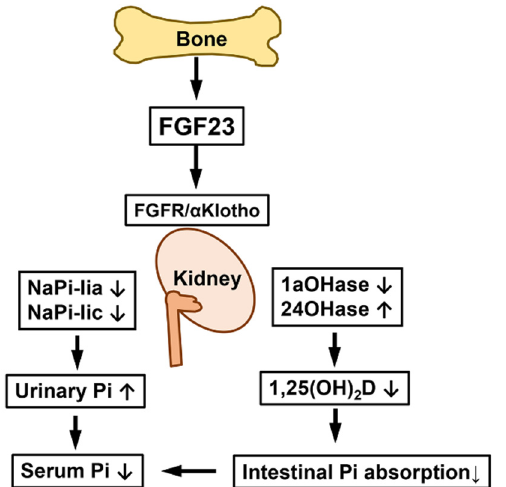
Figure 1. Effects of FGF23 on kidneys. FGF23 produced in bone binds to FGFR and α Klotho in the kidneys and suppresses the renal expression of NaPi-IIa and NaPi-IIc Na + /Pi co-transporters, which increases urinary Pi excretion and reduces serum Pi levels. In addition, FGF23 decreases the production of 1,25(OH) 2 D by the down-regulation of 25-hydroxyvitamin D-1 α -hydroxylase (1 α OHase) and up-regulation of 25-hydroxyvitamin D-24-hydroxylase (24OHase), which reduces the intestinal absorption of Pi and further lowers serum Pi levels.